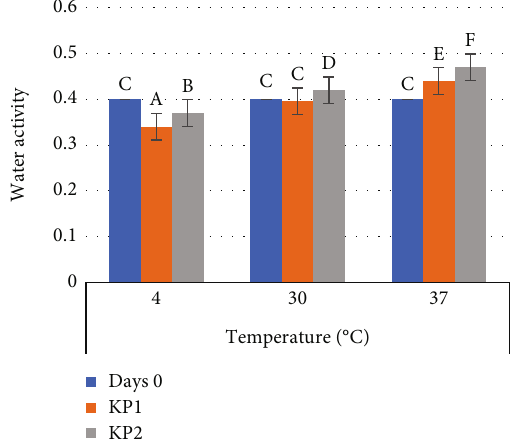
Figure 3: Water activity after storage. KP1: